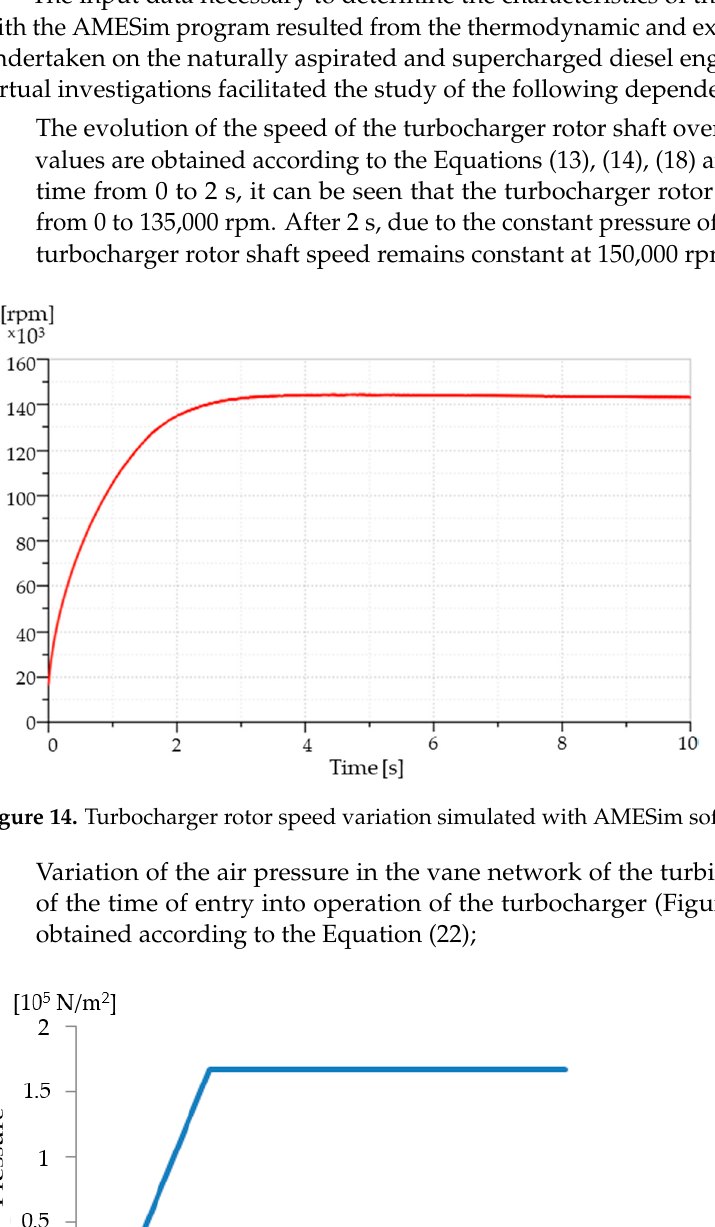
Figure 15. The compressor outlet pressure from the experimental results in relation to time .